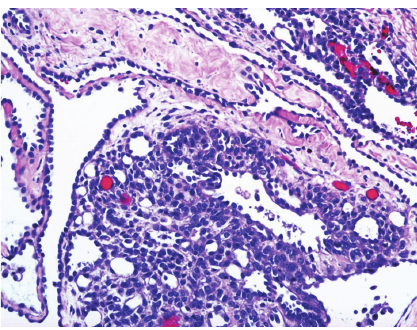
Figure 4: A section of the tumor shows the solid component of the tumor composed of Sertoli cells. Small tubular formation is noted in the solid component. Cuboidal Sertoli cells line the slit-like spaces (H&E, 200x).